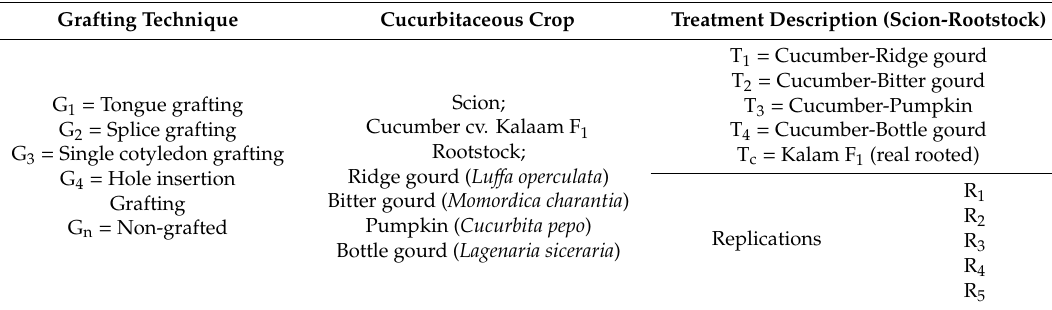
Table 1. Treatments, their level and replication for di ff erent grafting